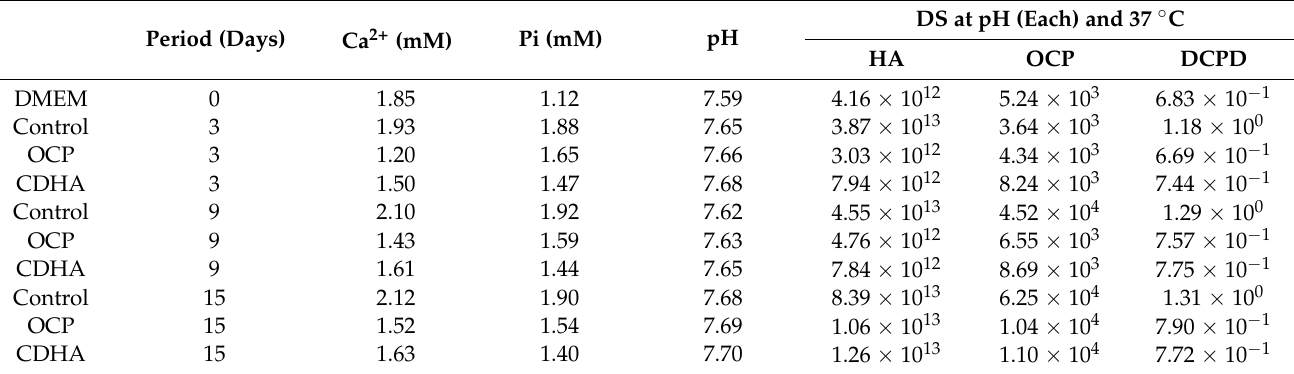
Table 1. Solution composition (Ca 2+ , Pi ion, and pH) and degree of supersaturation (DS) with respect to calcium phosphates in culture media incubated with OCP and CDHA.